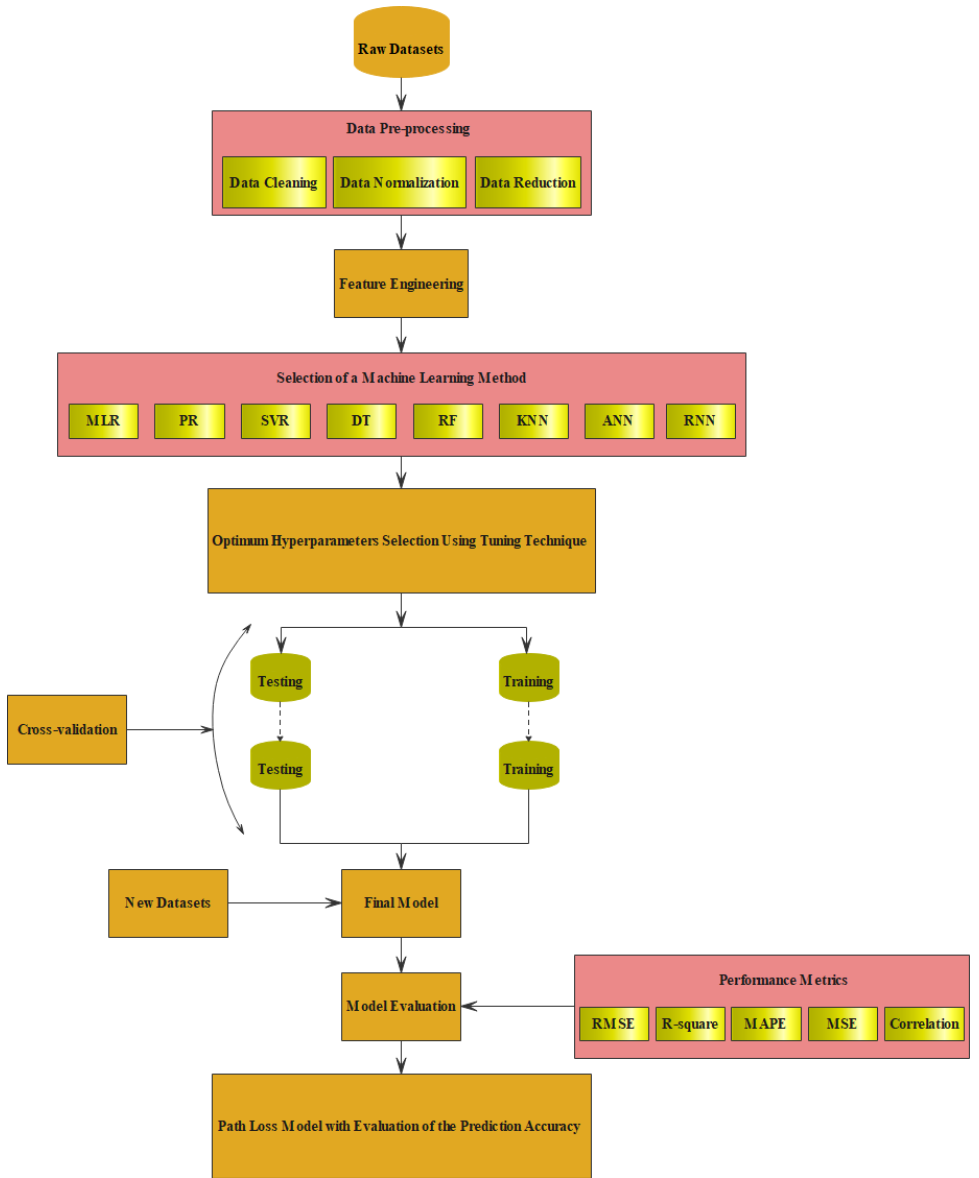
Figure 1. Flow chart of the adopted ML-based path loss prediction modeling